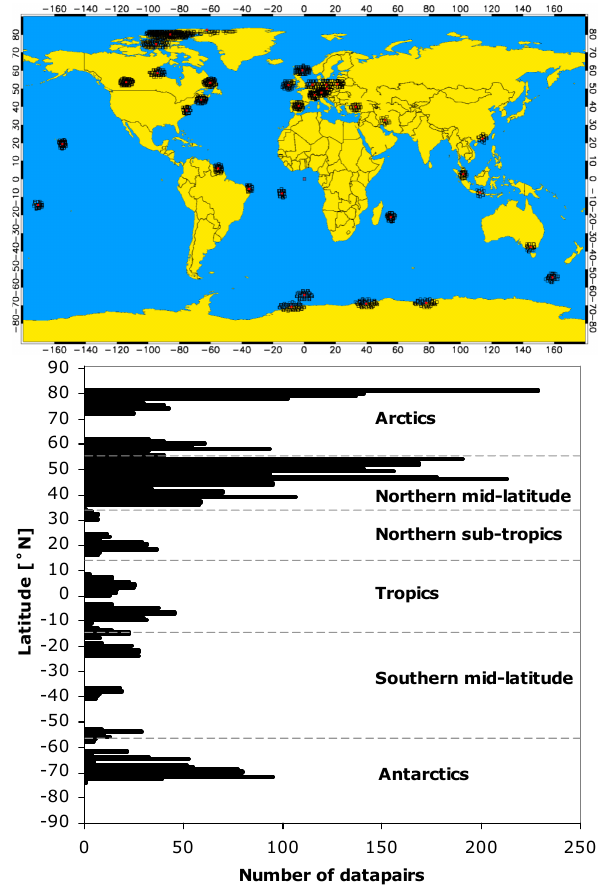
Fig. 3. Upper panel: location of the worldwide ozonesonde profiles Figure 3. Left panel: location of the worldwide ozonesonde profiles of WOUDC (red dots)1 of WOUDC (red dots) used in this analysis together with their co- incident TES measurements (squares). Lower panel: distribution of used in this analysis together with their coincident TES measurements (squares). Right panel:2 the amount of TES–ozonesonde matchups available for this study as a function of latitude. The dashed grey lines indicate the regions distribution of the amount of TES-ozonesonde matchups available for this study as a function3 used in this study to evaluate the TES biases in more detail. In the lower panel, the northern mid-latitude range: > 35–56 ◦ N, the Arc- of latitude. The dashed grey lines indicate the regions used in this study to evaluate the TES4 tic: > 56–82 ◦ N, the northern sub-tropics: > 15–35 ◦ N, the tropics: 15 ◦ S–15 ◦ N, the southern mid-latitude: > 35–56 ◦ S, the Antarctic: biases in more detail. In the right panel, the Northern mid-latitude range: > 35 - 56˚N, the5 > 56–82 ◦ Arctics: > 56 - 82˚N, the Northern sub-tropics: >15 - 35˚N, the Tropics: 15˚S - 15˚N, the6 Southern mid-latitude: > 35 - 56˚S, the Antarctics: > 56 - 82˚S.7